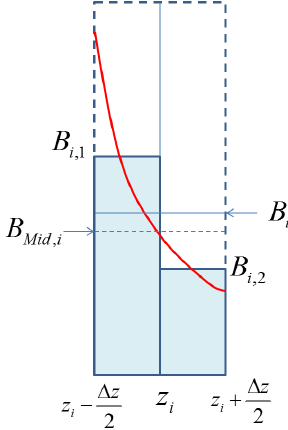
Figure A1. Illustration of the relationship between the continuous lidar scaled attenuated backscatter (red line), the bin-integrated av- erage B i and the half-bin integrated average values ( B i, 1 , together with B i, 2 ) and the mid bin value B Mid ,i